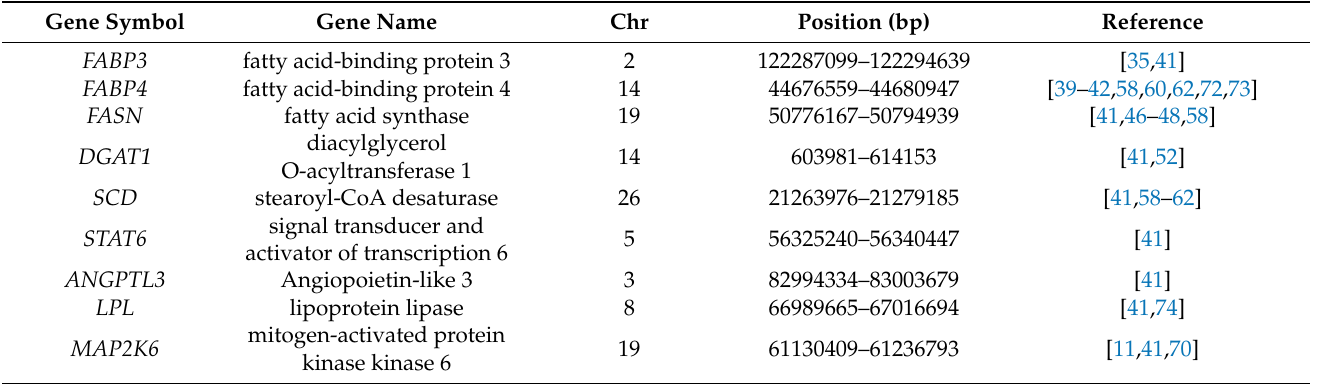
Table 1. Description and chromosomal location of the most important genes related to back fat thickness (marbling score) in Hanwoo